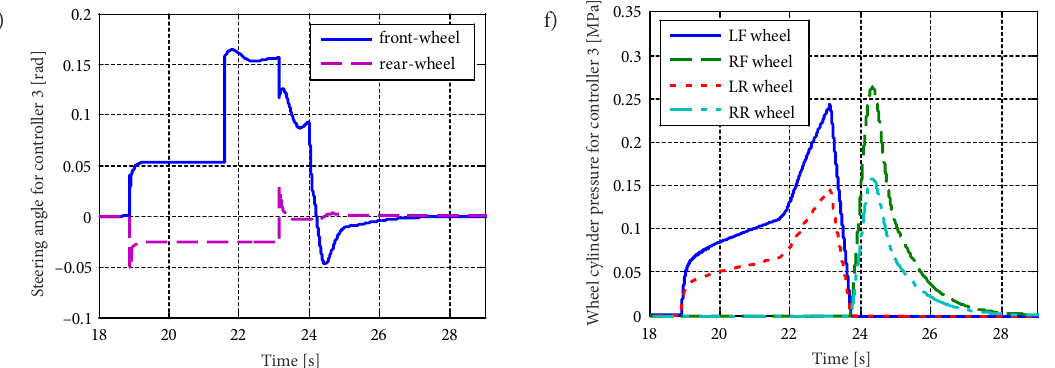
Figure 7. The steering angles and four brake cylinder pressures in the anti-sideslip simulation: a, b – red vehicle; c, d – blue vehicle; e, f – green